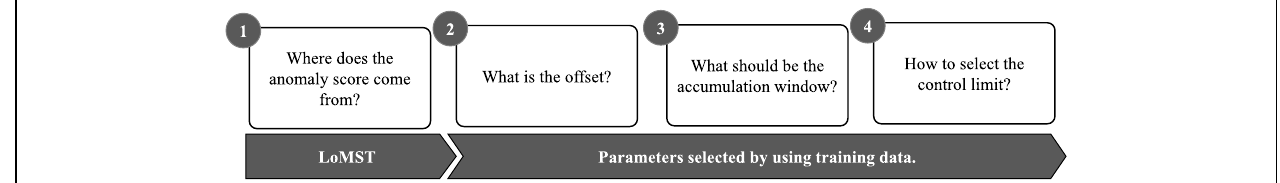
FIGURE 1 | The flowchart of the main steps in the CUSUM-inspired detection method.